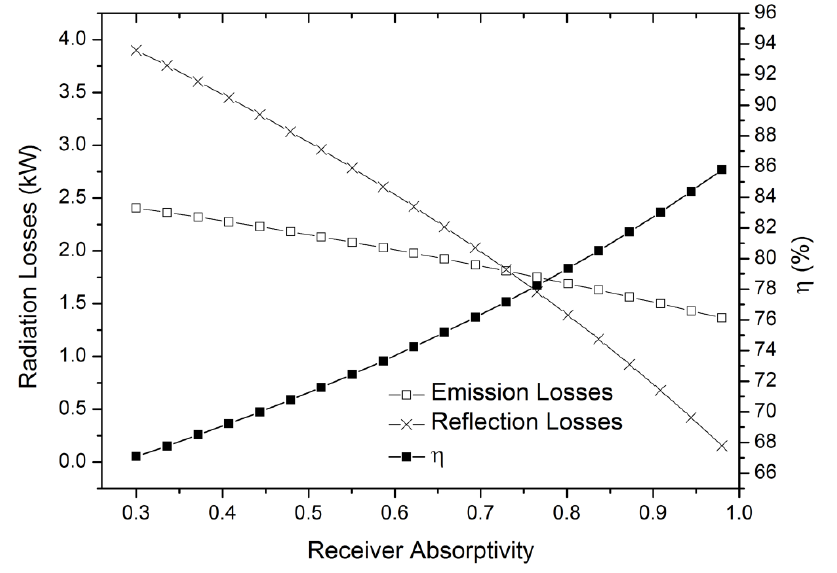
Figure 12. Efficiency and radiation losses varying receiver absorptivity (solar source: 28